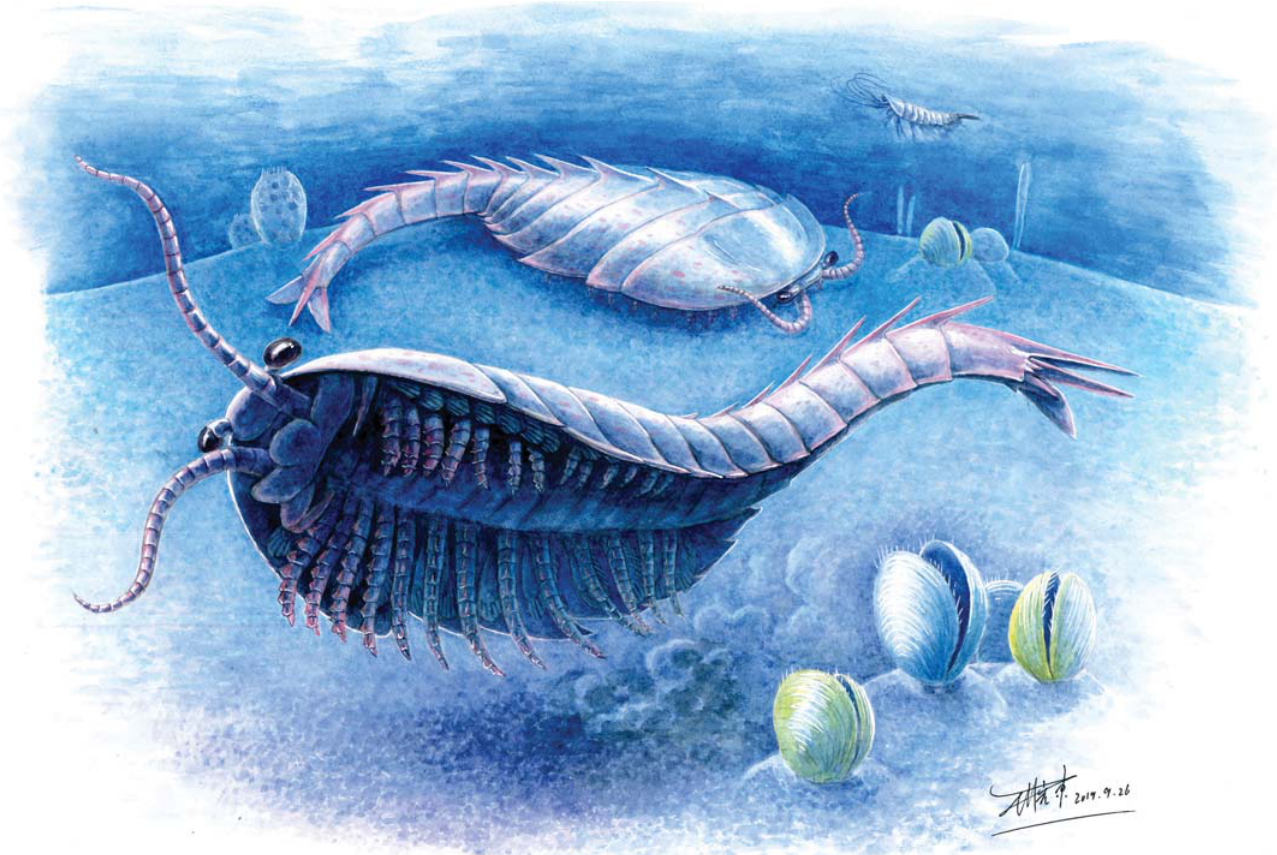
Fig. 5. Artistic reconstruction of Guangweicaris spinatus Luo, Fu, and Hu, 2007 from the lower Cambrian Guanshan Biota, China. Illustration by Xiaodong Wang (Yunnan Zhishui Corporation, Kunming,